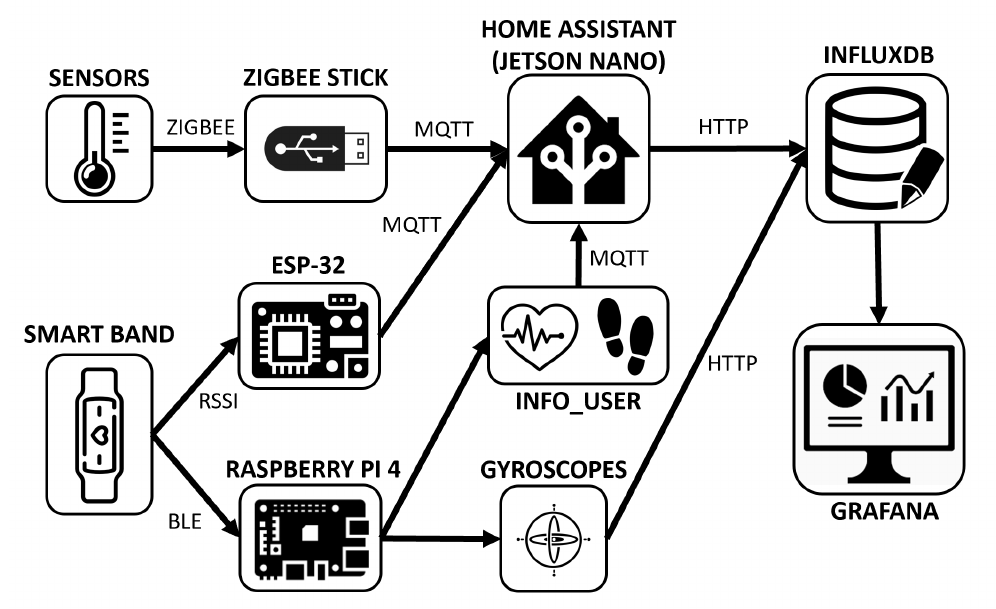
Figure 3. Communication diagram of the components of the non-intrusive monitoring